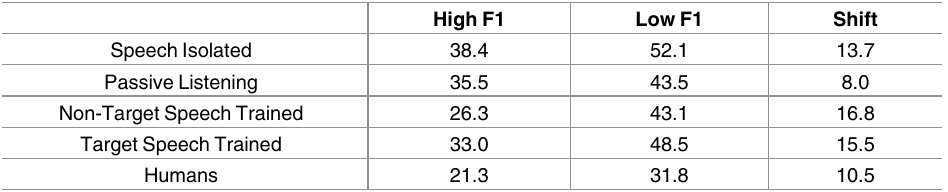
Table 2. Phoneme boundaries (in ms) for the low and high F1 onset da-ta continua and the amount of shift in the phoneme boundary (in